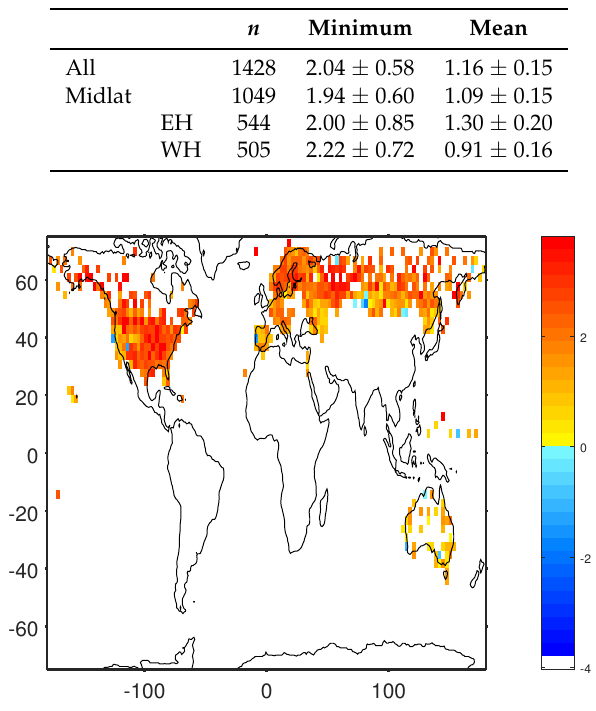
Figure 3. Increase in annual minimum temperature (°C) over 1970–2016, averaged on a 3° grid for visualization. Grid cells with no stations are left blank. The color scale is centered on 0, and the interval shown in the color bar covers 95% of the observations.